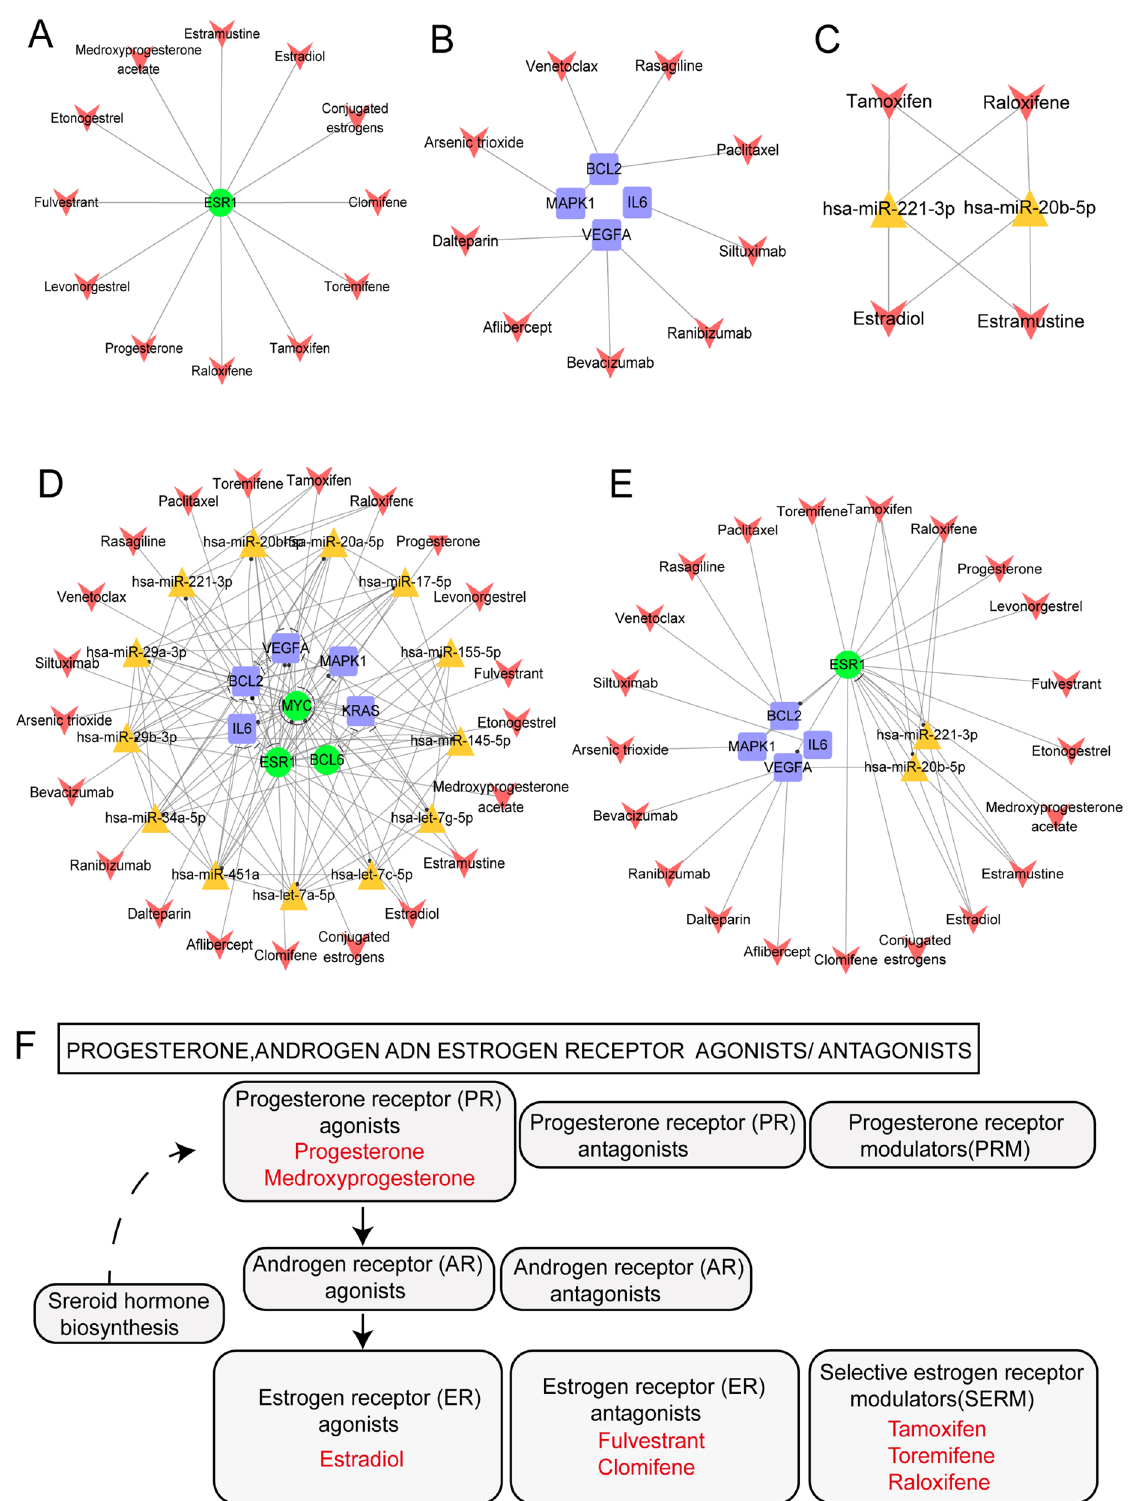
Figure 5. CFMSN and associated drugs. ( A ) A sub-network of TF in CFMSN and selected drugs. ( B ) A sub- network of genes in CFMSN and selected drugs. ( C ) A sub-network of miRNAs in CFMSN and selected drugs. ( D ) A global view of CFMSN and selected drugs through TFs, genes and miRNAs in CFMSN. ( E ) A sub- network of selected drugs targeted with screened TFs, genes and miRNAs. Orange triangle represents miRNA, green round represents TF, blue square represents gene and red “V” represents drug. ( F ) Part of pathway 07,226: Progesterone, androgen and estrogen receptor agonists/antagonists. Drugs colored in red are from 21 drugs we selected. CFMSN: 3/4/5-node composite FFL motif-specific sub-network; TF: transcription